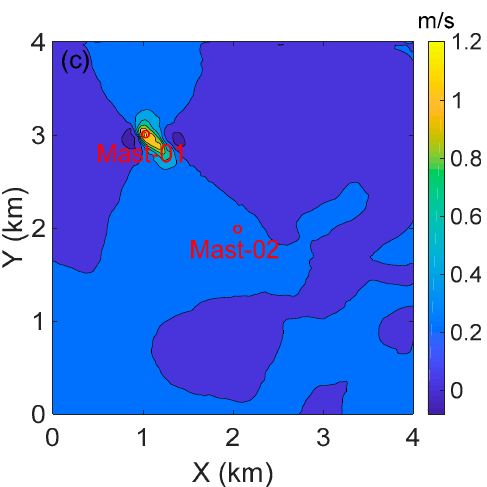
Figure 15. The v velocity component cross-section at 400 m altitude: ( a ) CFD model simulation without assimilation; ( b ) CFD model simulation with assimilation; ( c ) difference between the CFD model simulation without and with assimilation.